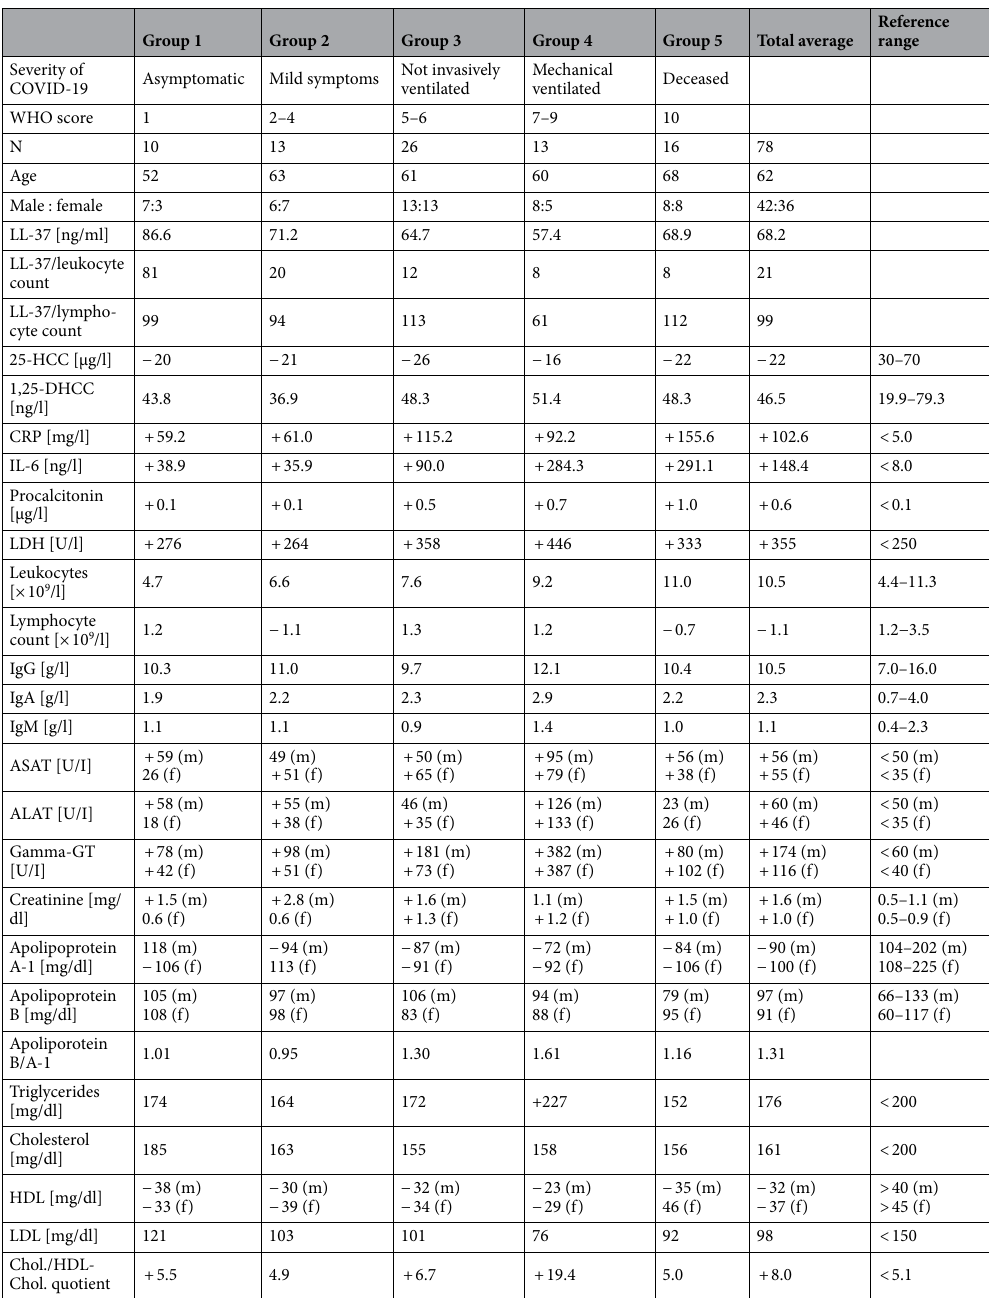
Table 1. Clinical characteristics and laboratory data. The clinical characteristics and laboratory data obtained in the study. The mean values of the groups and the reference ranges are listed. Values below the reference range are marked with a minus, values above with a